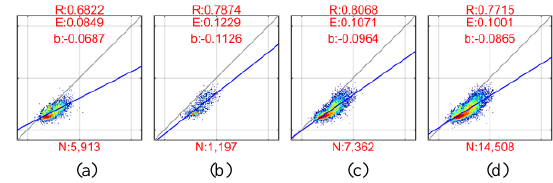
Figure 6. The impact of ephemeral snow cover event on accuracy of MCD43A1